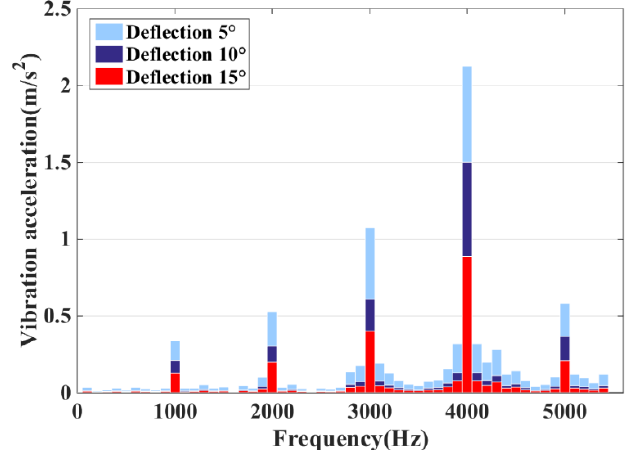
Figure 19. Vibrating surface acceleration at different deflection angles.